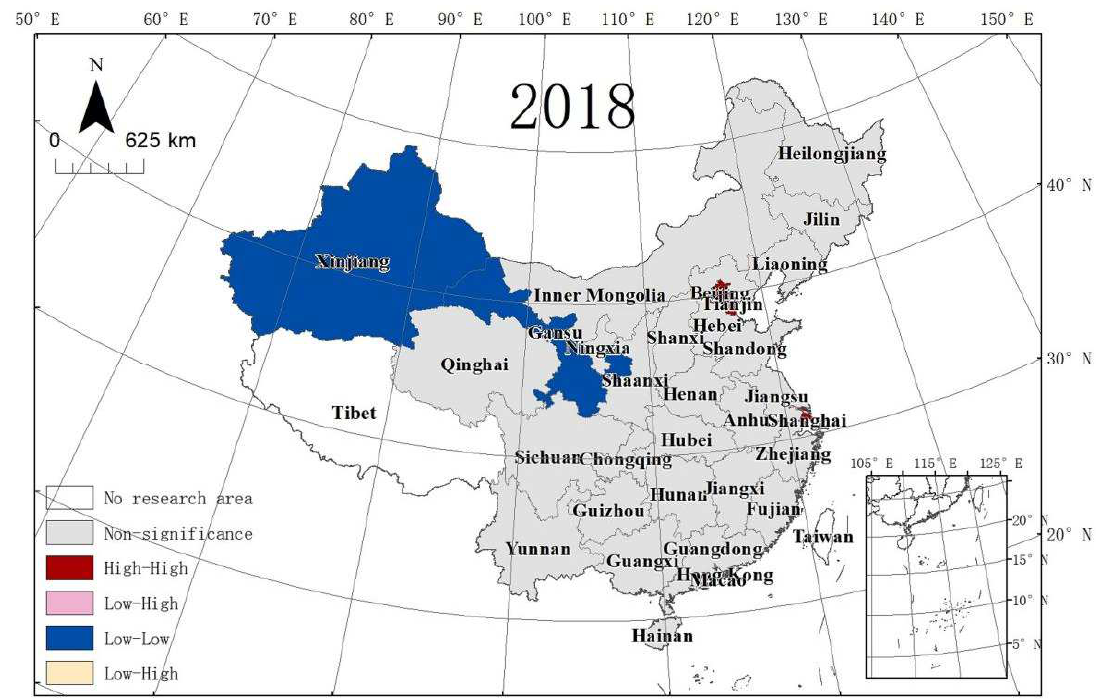
Figure 10. LISA of ULGLE in 30 provinces in 2018.